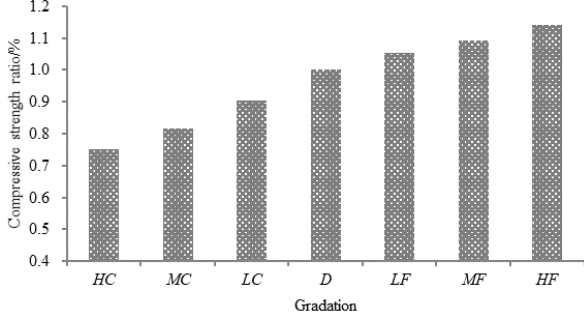
Figure 8. Compressive strength ratio of the asphalt mixture.